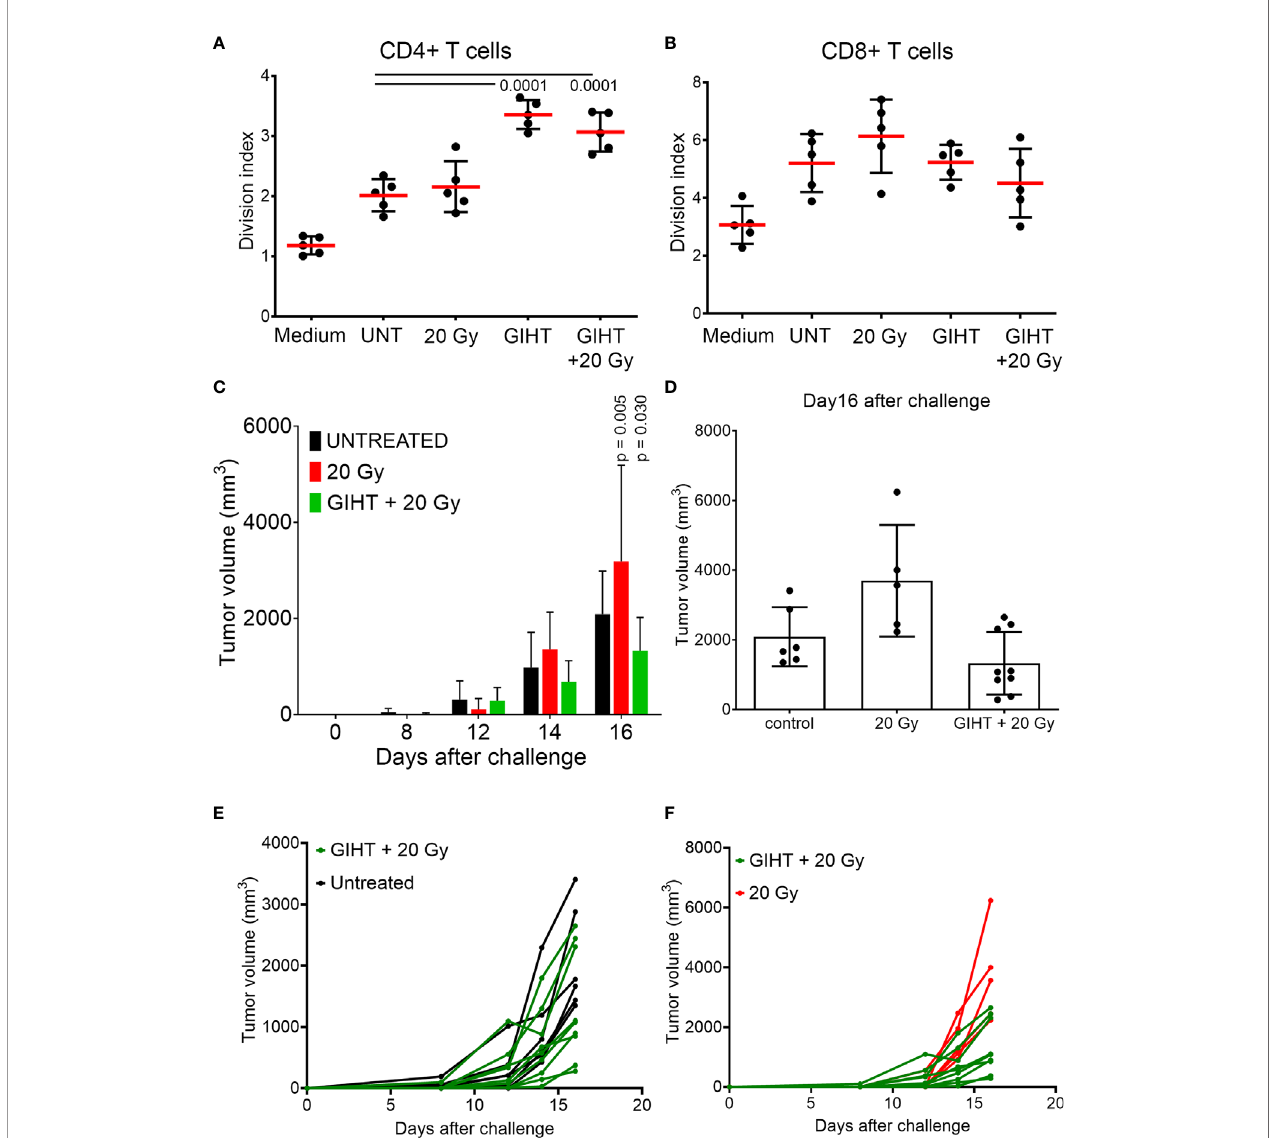
FIGURE 5 | Induction of speci fi c anti-tumor immune responses. T cells proliferation induced by conditioned DCs. DCs were co-incubated for 24 hours with SN collected from B16F10 melanoma cells exposed to indicated treatments. CSFE-labelled T cells were co-cultured with DCs for 4 days. To show bottom-line proliferation, DCs were conditioned with fresh medium. Division index of CD4 positive T cells (A) and CD8 positive T cells (B) is shown. Kruskal-Wallis test with Dunn ’ s multiple comparison test was employed. Values of p < 0.05 were considered as signi fi cant. (C) Tumor growth after challenge of immunized mice. Immunization was performed with a single i.p. dosis of detached B16F10 melanoma cells including their supernantants. Fourteen days after the immunization, mice were challenged with viable B16F10 melanoma cells injected subcutaneously in the back. Two-way ANOVA was used to compare the means at each time point. Values of p < 0.05 after Tukey ’ s multiple comparison test were considered as signi fi cant and depicted. (D) Tumor volume of immunized mice at day16 after the challenge with viable B16F10 melanoma cells. One way ANOVA was applied to evaluate the means at day 16 after challenge. (E , F) Tumor growth of single mice of the experiment shown in (C) . P values of Fisher´s least signi fi cant differences are depicted. Gy, Gray; GIHT, graphene-induced